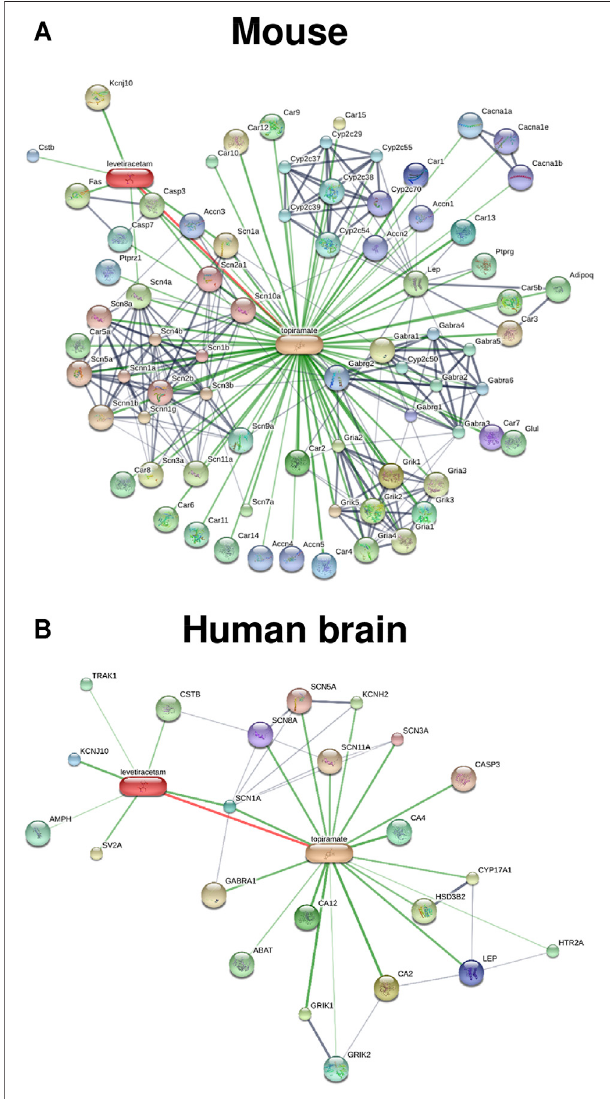
FIGURE 8 | Known and predicted drug-drug protein network interactions of the combination of levetiracetam and topiramate analyzed in silico by the STITCH database for the mouse (A) and the human brain (B) . Tissue-speci fi c interactions are not yet available for the mouse, explaining the higher number of interactions obtained in the mouse vs the brainofhumans.Drug-protein andprotein-proteinnetworksareshown bythe con fi dence view of the database, in which stronger associations are represented by thicker lines. Drug-protein interactions are shown in green, protein-protein interactions in grey, and interactions between drugs in red. In both species, drug interactions between levetiracetam and topiramate exist, which is indicated by the red line. Interestingly, the proteins by which the two drugs interact seems to be different in the two species (see the STITCH database (http://stitch.embl.de/) for abbreviations of proteins). However, as discussed in the text, one major disadvantage of the STITCH database is that it does not contain information on disease-associated alterations in protein networks and drug targets.